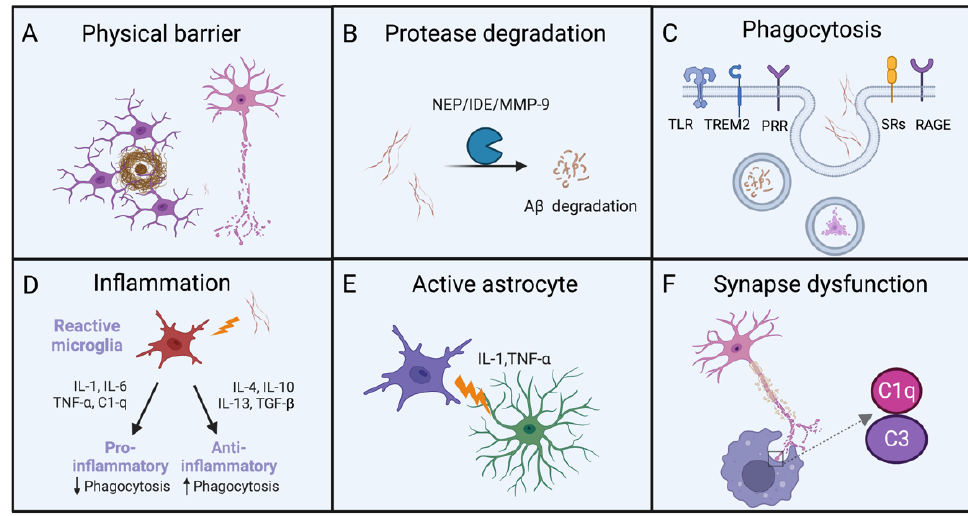
Figure 1. Clearance of A β by glial cells. ( A ) Microglia form a physical barrier to protect neurons. ( B ) Increasing the breakdown by microglial proteases could enhance the clearance of A β deposits. ( C ) The phagocytic activity of microglia could be enhanced by targeting receptors and signal pathways involved in this response. ( D ) Inflammation caused by microglia produce both pro-inflammatory and anti-inflammatory factors. ( E ) Microglia can secrete cytokines to activate astrocytes. ( F ) Microglia participate in amyloid-dependent synaptic dysfunction.